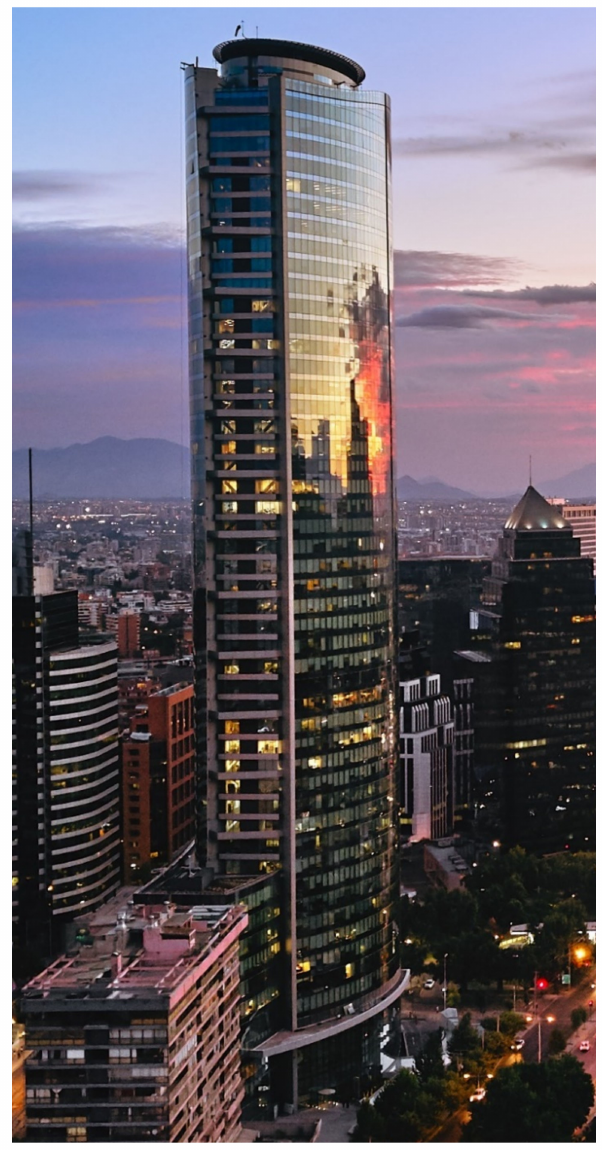
Figure 8. Titanium La Portada Building: https://upload.wikimedia.org/wikipedia/commons/ thumb/7/74/Titanium_La_Portada_%2838888739395%29.jpg/360px-Titanium_La_Portada_%283 8888739395%29.jpg (accessed on 15 October